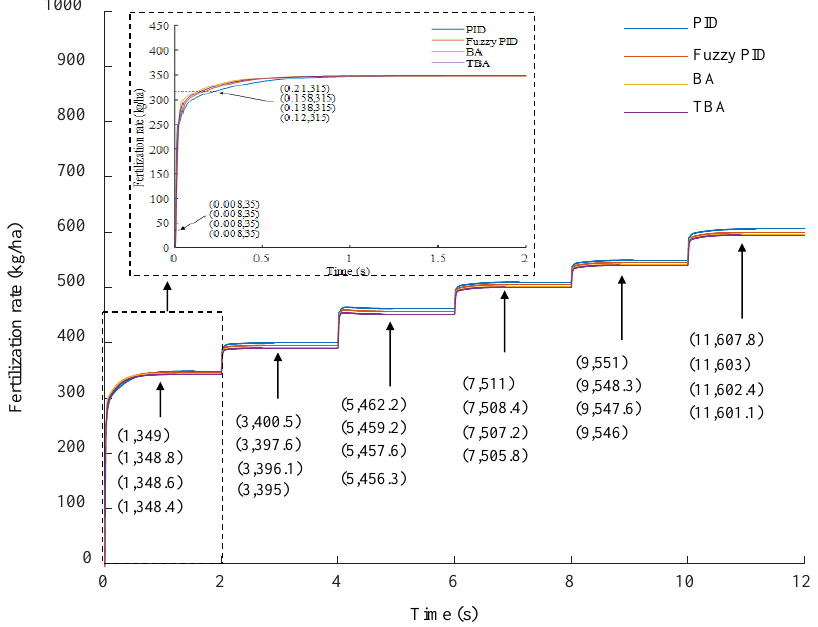
Figure 8. Simulation of fertilization-rate regulation from 350 kg ha −1 to 600 kg ha −1 .